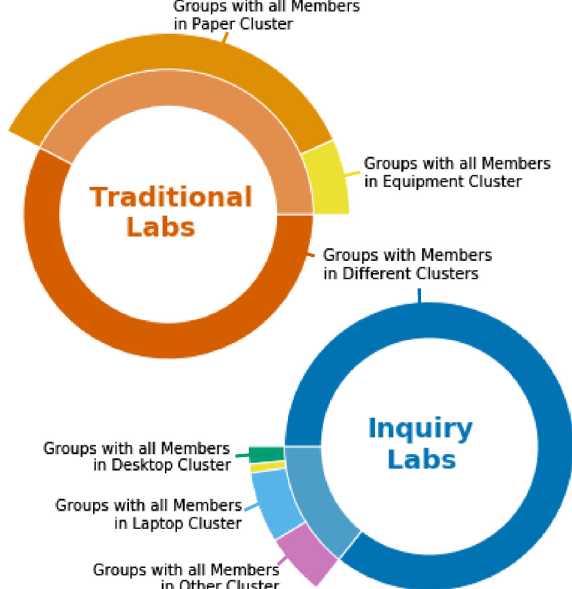
FIG. 7. Fraction of groups with members in identical clusters (light ring) and different clusters (dark ring) illustrating role division in the different labs. Almost half of groups in the traditional labs had all members in the same cluster (primarily paper cluster), whereas the majority of groups in the inquiry labs had members in multiple clusters indicating an increase in task division.